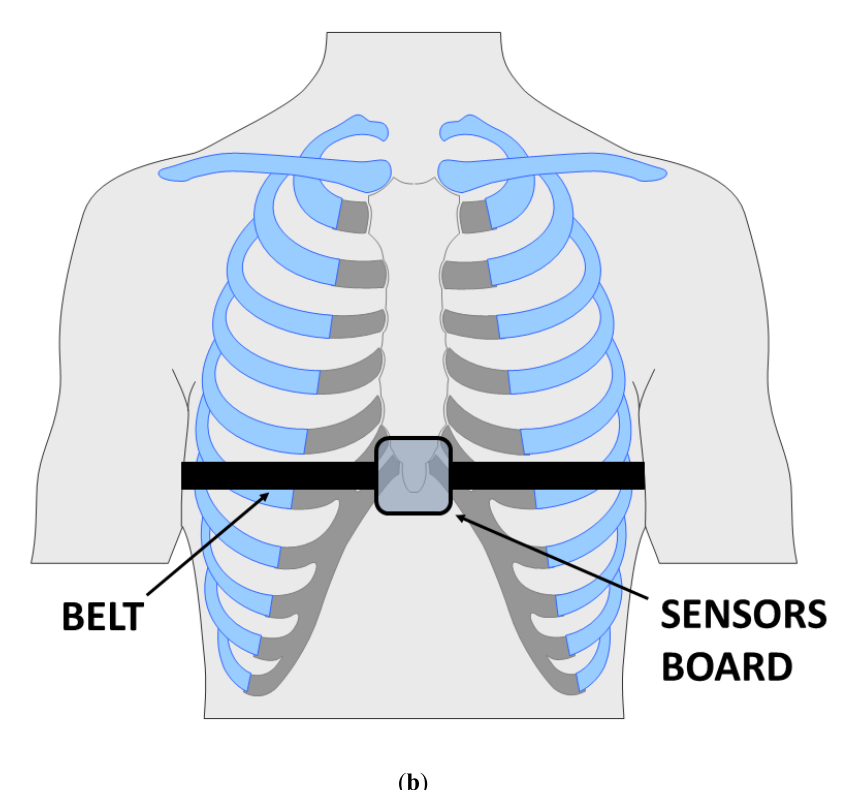
Figure 2. ( a ) Side and top views of the sensors board; ( b ) sensors board positioning.